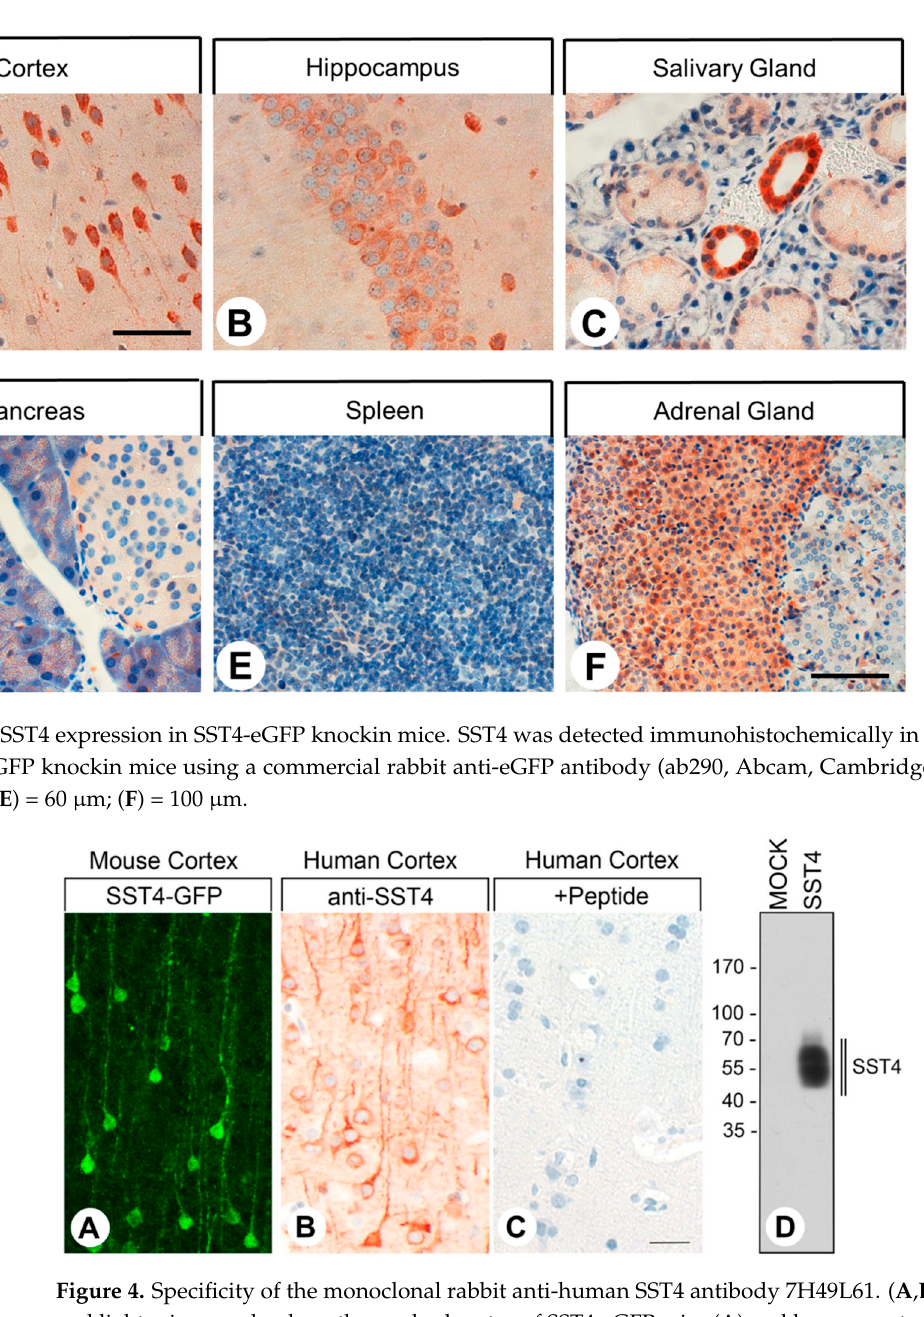
( C ) For adsorption controls, 7H49L61 was preincubated with 10 µ g/mL of the peptide used for immunization. Scale bar: ( A ) = ( B ) = ( C ) = 50 µ m. ( D ) Immunoblot analysis using 7H49L61